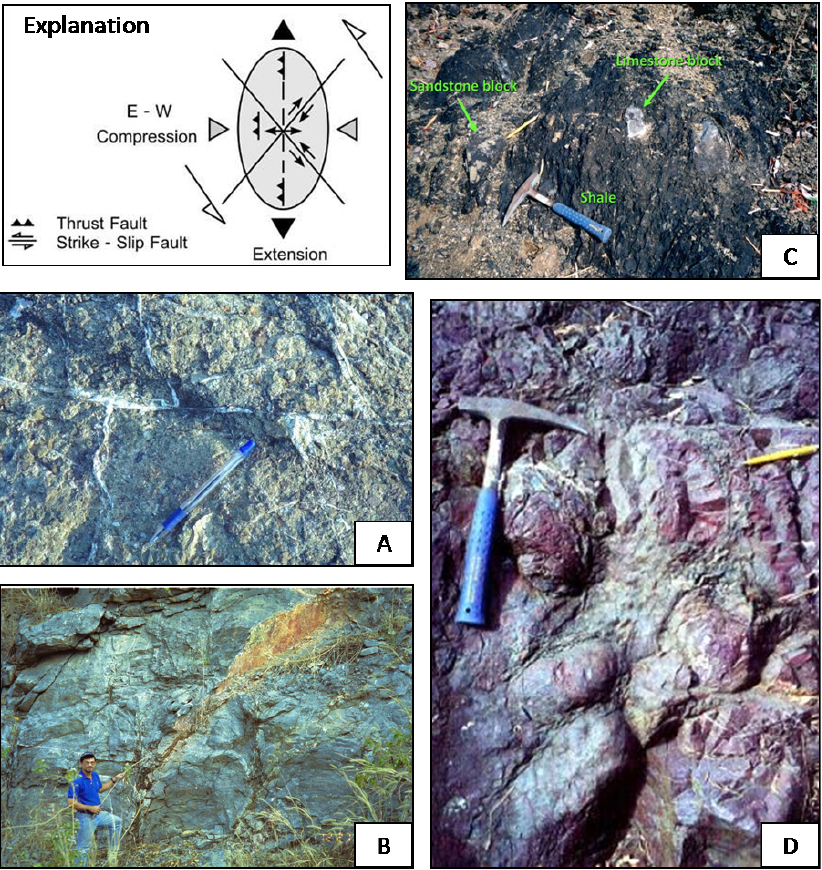
Figure 5. Evidence from the field survey results: (A) An ellipsoid-showing fault orientation and sense of movement interpreted from the outcrop, which is a fault plane oriented in the norteast-southwest direction, 5 km south of Wang Nam Yen district, Sra Kaeo, indicating a dextral strike-slip sense of movement (top of pen points to the north). (B) A road-cut exposure of thick-bedded Late-Paleozoic limestone, 2 km south of Wang Nam Yen district, Sra Kaeo, showing the northwest-southeast reverse fault. (C) Exposure of the mélange zone, containing sandstone and limestone blocks set in a shale matrix, 10 km south of Wang Sombun district, Sra Kaeo [Chutakositkanon et al. 2003]. (D) A road-cut exposure of pillow lava basalt, 5 km west of Wang Sombun district, Sra Kaeo.